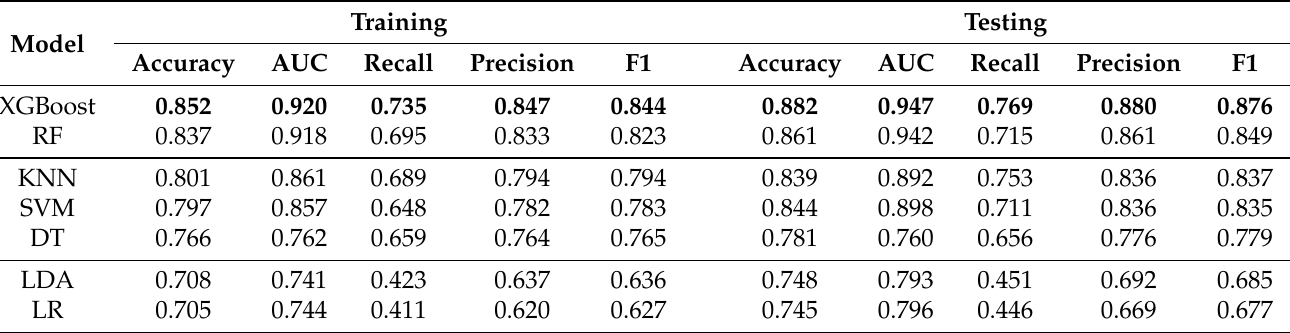
Table 3. Overall performance of different machine learning models in lithology classification, with best metrics achieved in each column are highlighted in bold.